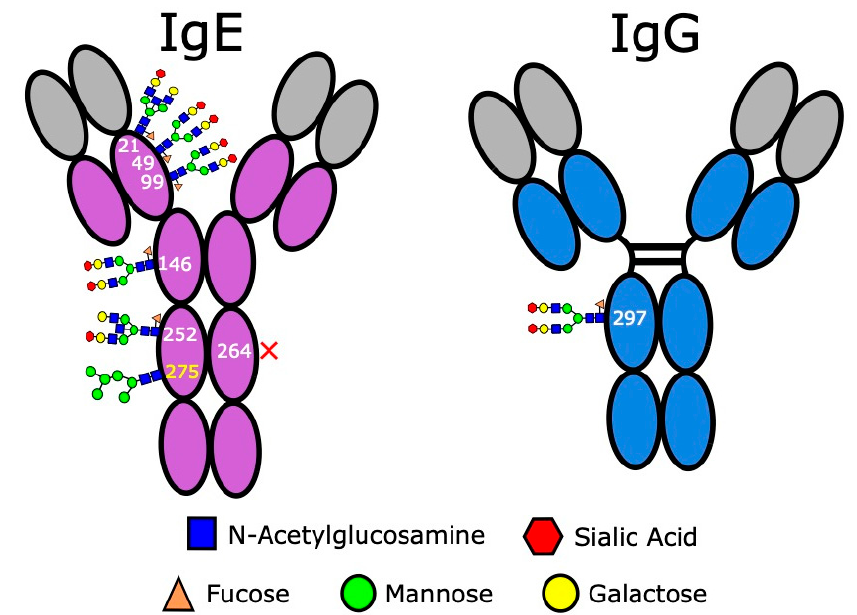
Figure 4. IgE is a heavily glycosylated molecule, with 7 documented N-glycan sites. Site N275 (highlighted yellow) is occupied by a simple-type oligomannose glycan. Site 264 has been found to be consistently unoccupied (indicated by red cross). All remaining sites are occupied by complex type glycans. Glycosylation patterns shown here are adapted from Plomp et al. [89]. In comparison, IgG has one detectable glycan in its Fc region, and in around 20% of IgG molecules there may additionally be glycosylation in the Fab region. In both antibody classes there is evidence that pathophysiological states and individual variation can result in differential glycosylation, so glycan composition shown here is representative rather than indicative of specific glycosylation patterns.